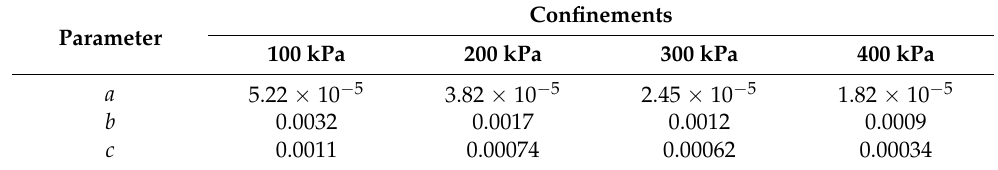
Table 6. Model parameter of Shen model.